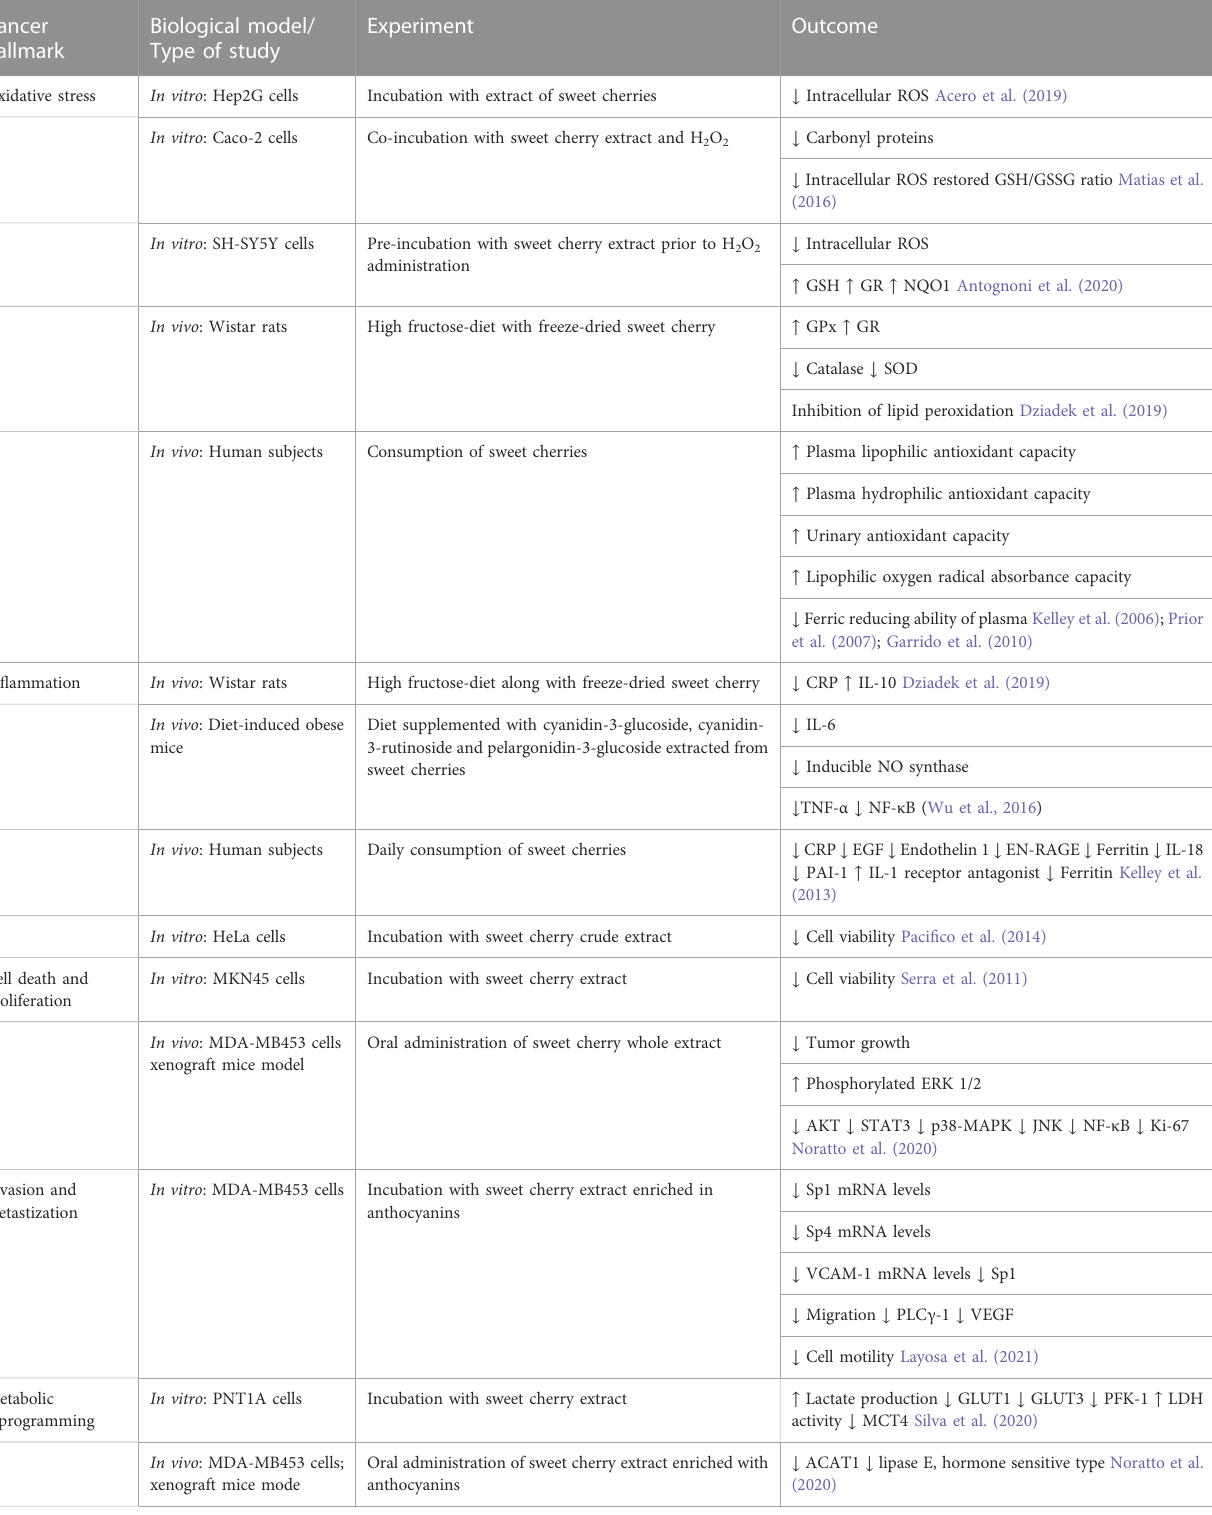
TABLE 2 Biological properties of Prunus avium extracts and their bioactive compounds that target hallmarks of cancer. Cancer